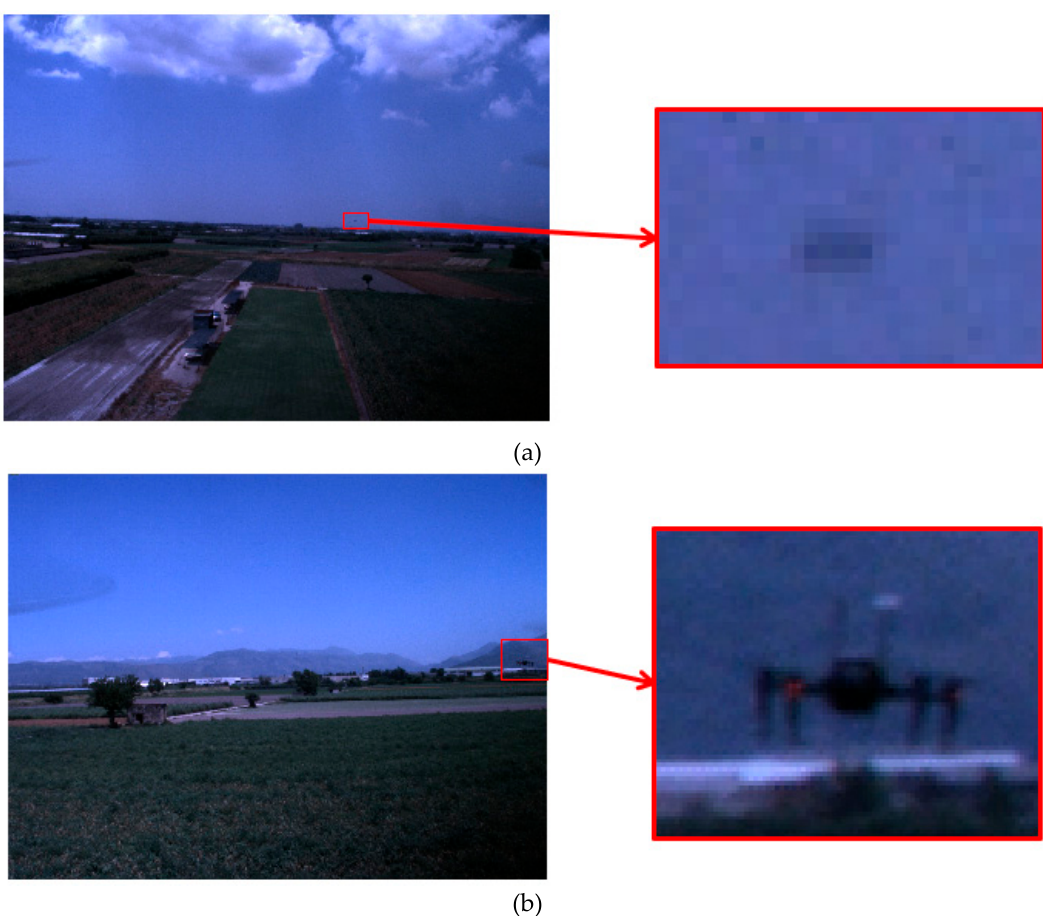
Figure 12. Example of images from FT1-B (a) and FT2-B (b).